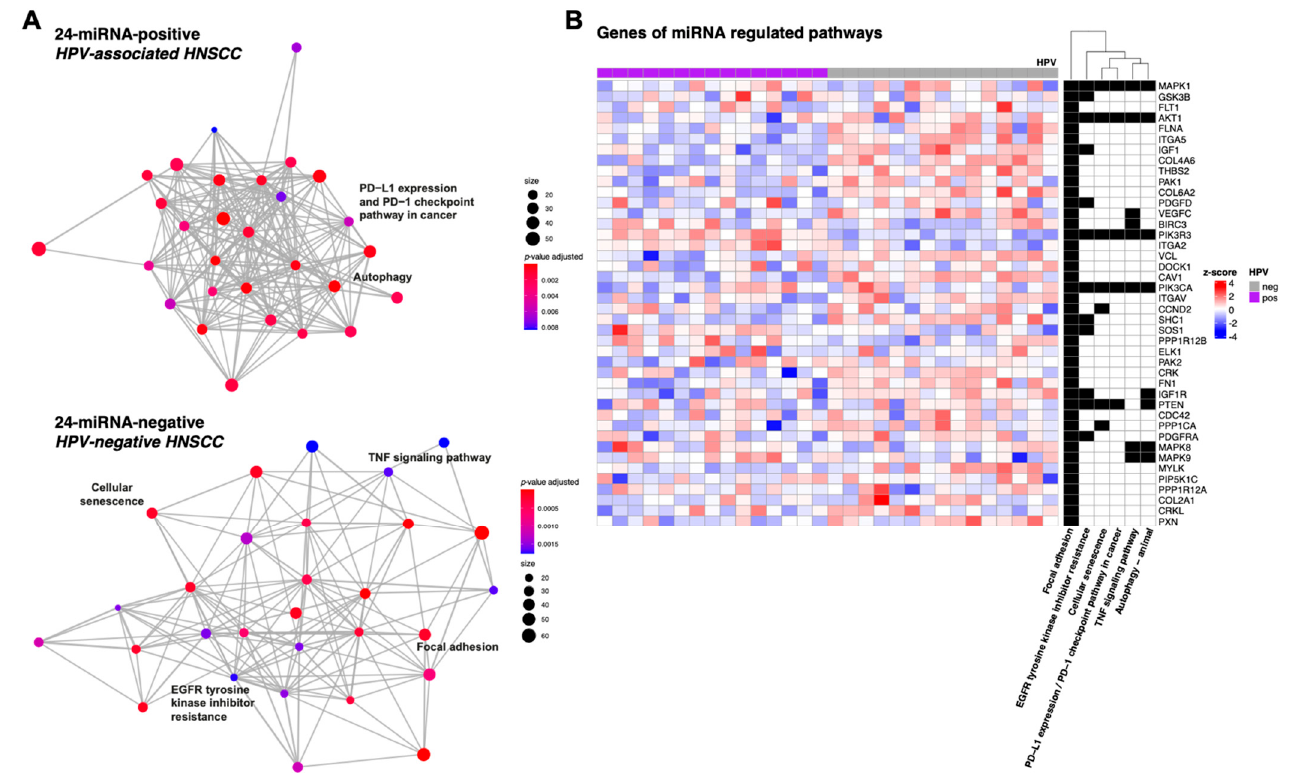
Figure 5. Pathway enrichment of 24 signature miRNA-mRNA interactions. ( A ) Enrichment maps with significantly enriched KEGG pathways (adjusted p -values < 0.05) of the top 1000 miRNA-mRNA interactions. Information on gene count/size (i.e., the number of genes enriched in a KEGG pathway) is given. Pathways occurring exclusively in 24-miRNA-positive/HPV-associated (upper panel) or 24-miRNA-negative/HPV-negative tumours (lower panel) are labelled. ( B ) Heatmap including genes of identified significantly enriched pathways exclusively associated with miRNA-mRNA interactions in 24-miRNA-positive/HPV-associated and 24-miRNA-negative/HPV-negative HNSCC. Heat map colours indicate mRNA expression z-scores on a scale of − 4 to 4.